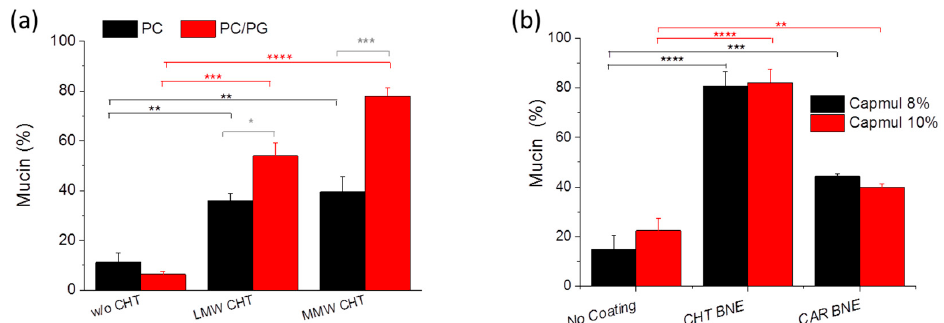
Figure 8. Mucoadhesive properties (expressed as the capability to adsorb mucin (% adsorbed)) of: ( a ) CHT-coated LIPs and ( b ) CHT- or CAR-coated NEs. Non-coated formulations were evaluated under identical conditions (in all cases) for comparison. *: p ≤ 0.05; **: p ≤ 0.01; ***: p ≤ 0.001; ****: p ≤ 0.0001.